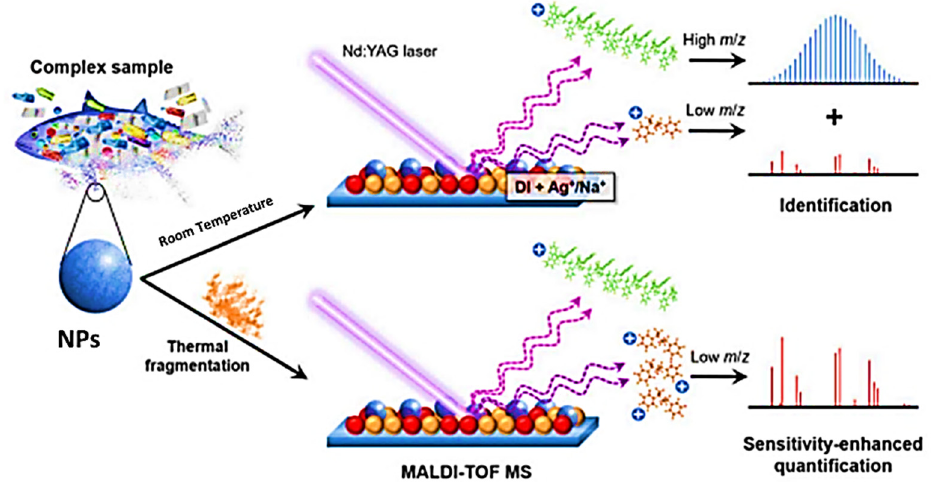
Figure 13. Schematic representation of the protocol for thermally improved detection and quantification of PS NPs by MALDI-TOF MS. Ref [144] Reproduced with permission from Lin et al., Talanta; published by Elsevier, 2019.